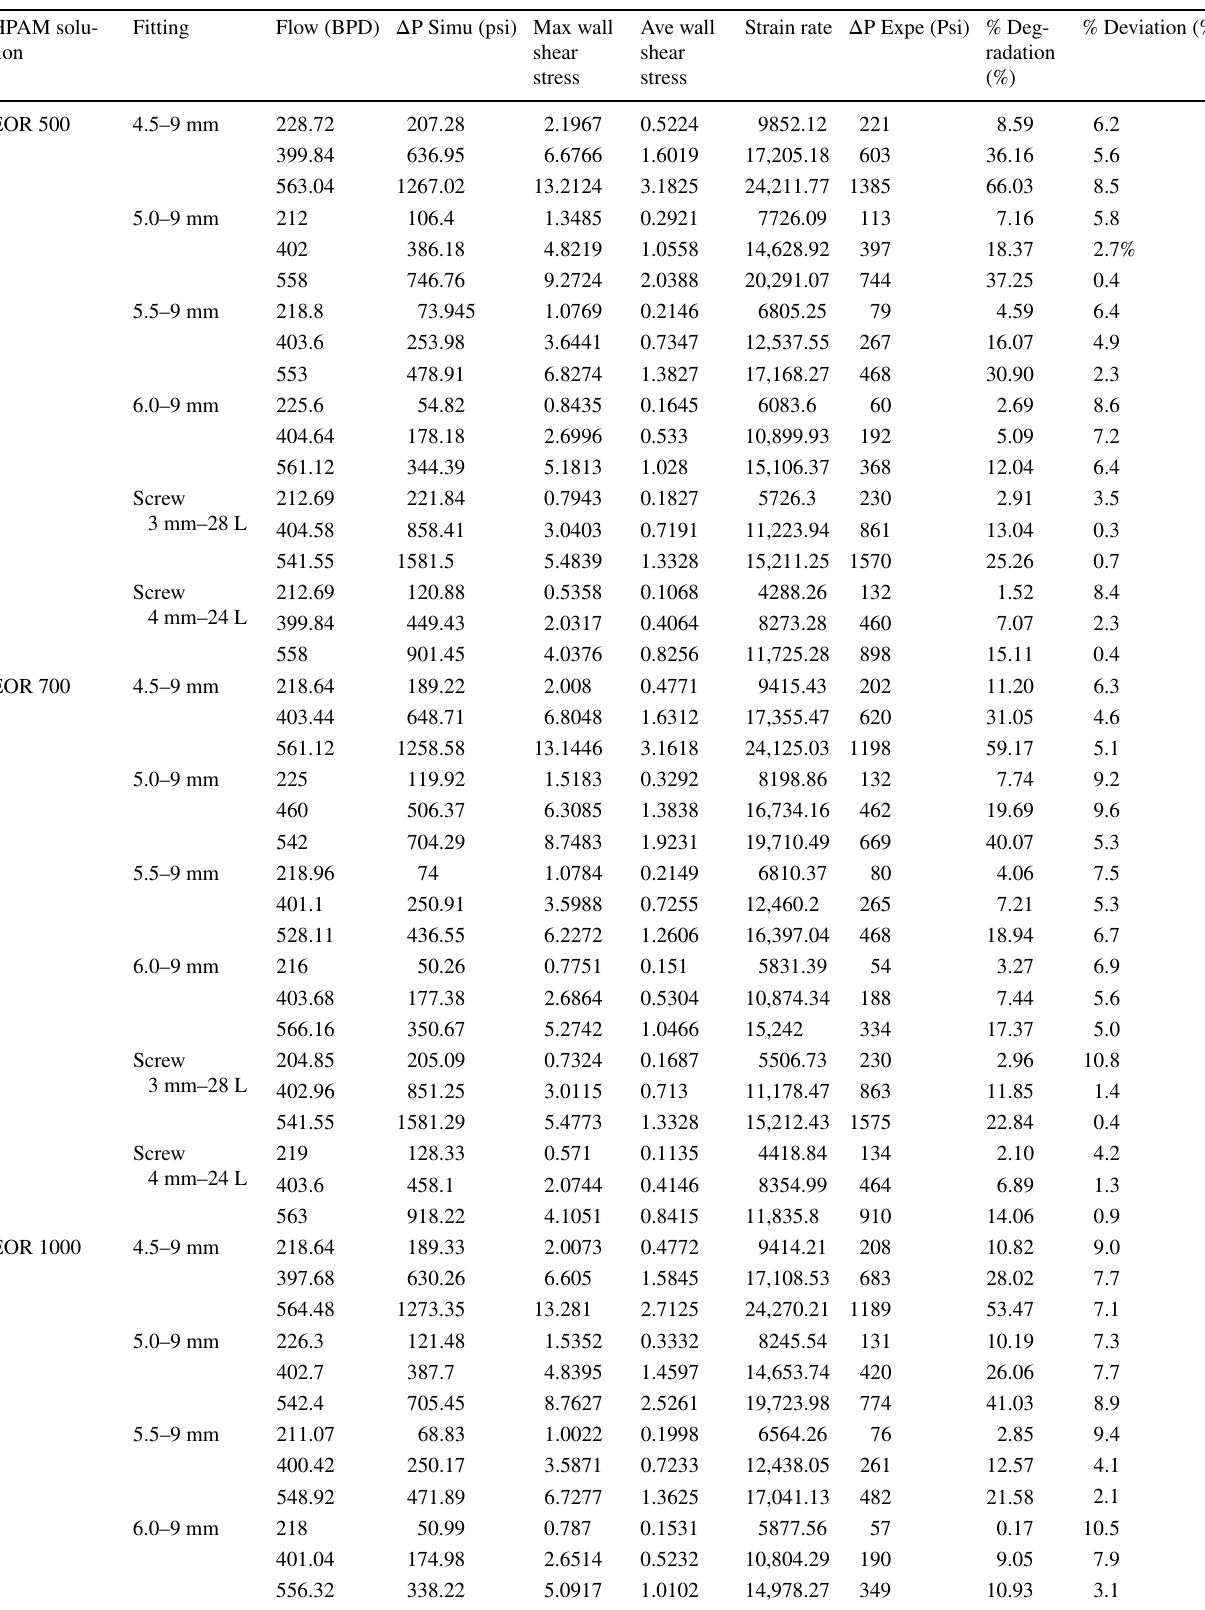
Table 3 Complete set of experimental and simulation results HPAM solu-